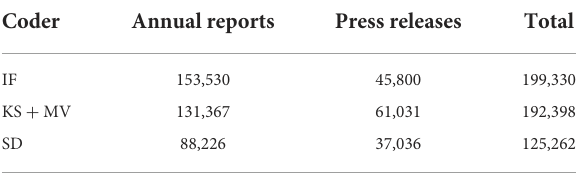
TABLE 4 Content coded by each coder across content type (words).